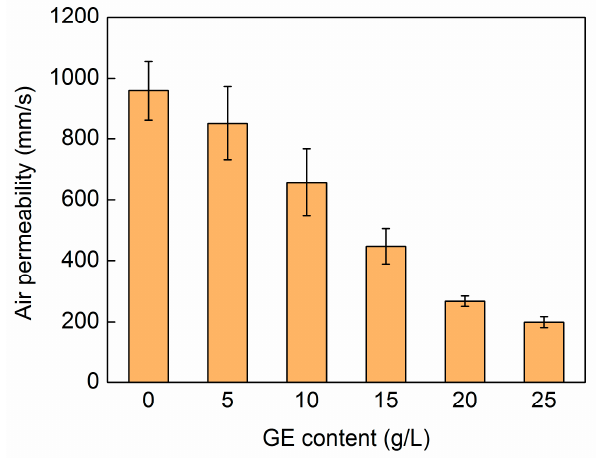
Figure 6. Air permeability of composites with various coating agent GE content.